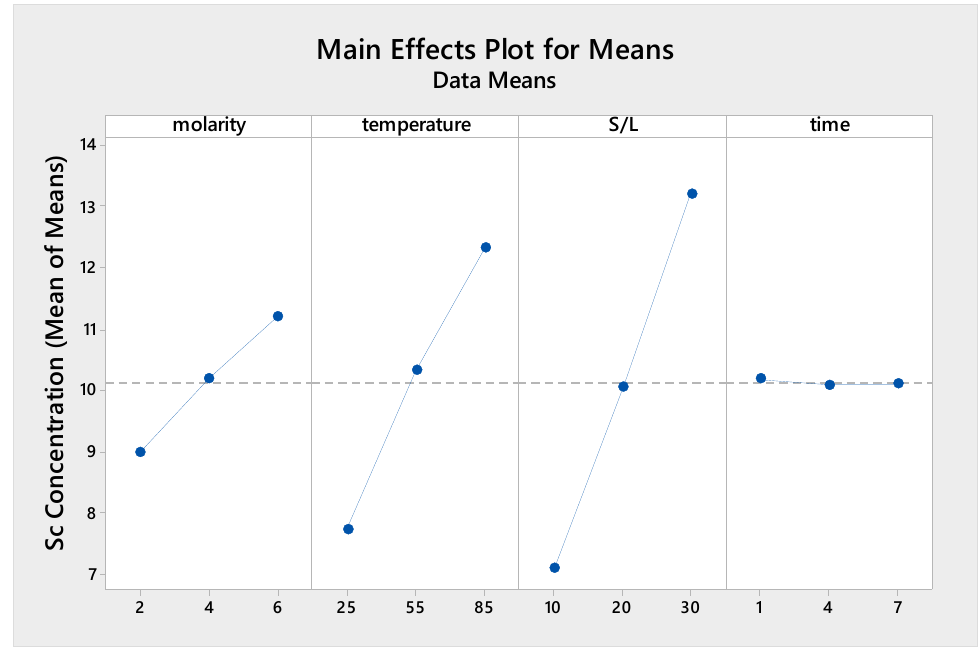
Figure 1. Effects of each parameter (( A ) Acid molarity, ( B ) Temperature, ( C ) Solid-to-Liquid ratio (S/L), and ( D ) Leaching time) associated with their levels on Sc concentration.